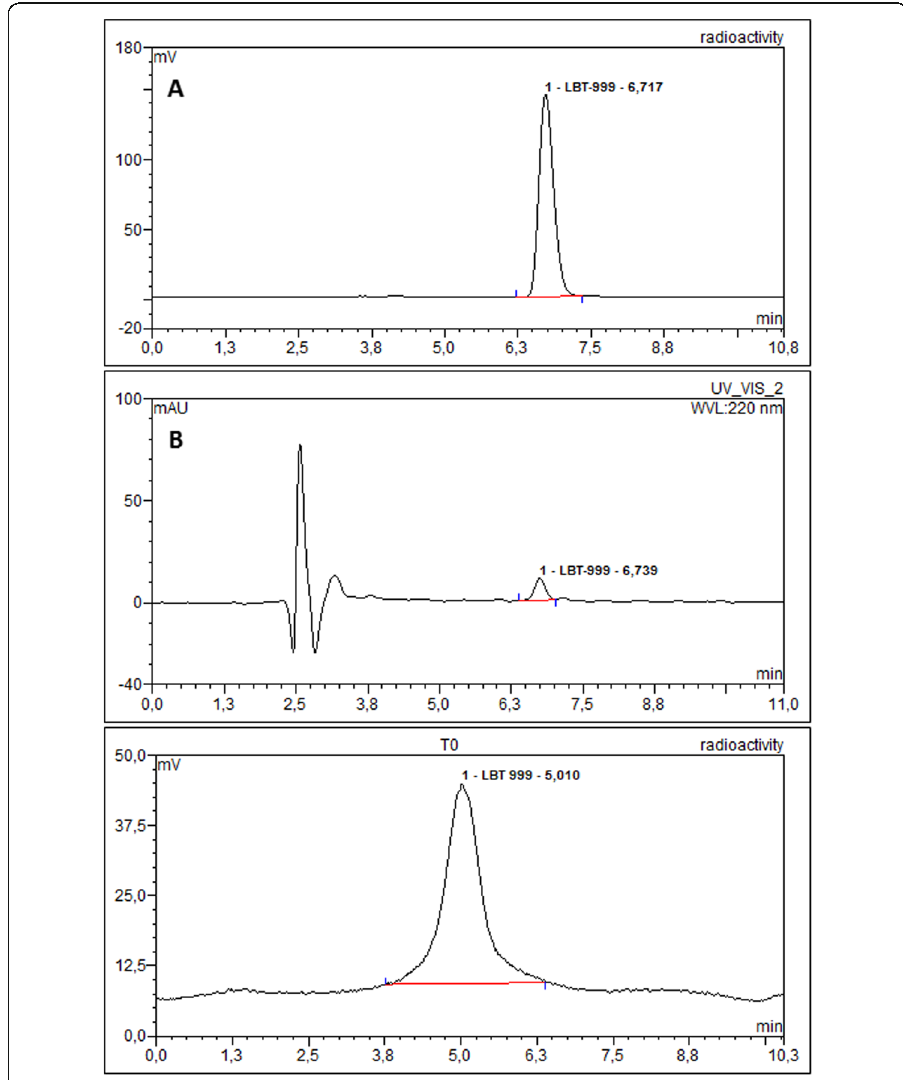
Fig. 5 A/ and B/ Chromatograms (gamma and UV) obtained with a μ Bondapak ™ column at the end of [ 18 F]LBT999 production on the TRACERlab FXFN. C/ Radio-TLC chromatogram of [ 18